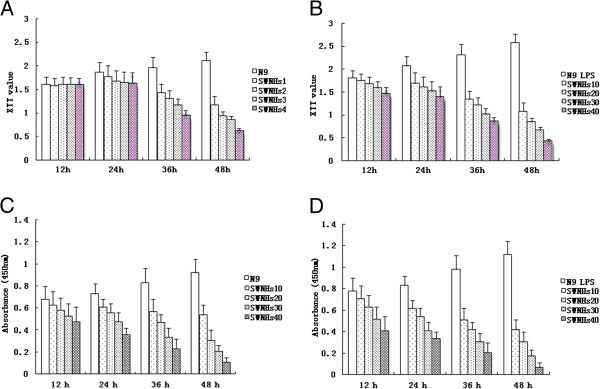
SWNHs inhibited growth and proliferation of N9 cells, especially in pre-treated with LPS. By XTT assays, we investigated the effect of SWNHs on cell growth and found that the growth of N9 cells pre-treated with LPS (B) was much more significantly than N9 cells (A). The growth of cells were significantly inhibited by SWNHs at each time point in a dose-dependent manner (P < 0.001), especially in cells pre-treated with LPS (B). Cell viability was evaluated by CCK-8 assay. The result showed that the proliferation of N9 cells pre-treated with LPS (D) was much more significantly than N9 cells (C). The proliferation of N9 cells treated with SWNHs was significantly inhibited at each time point in a time and dose-dependent manner (C and D). The effect induced by SWNHs on N9 cells pre-treated with LPS (D) was far more than that cells pre-treated without LPS (B). All data are represented as mean ± SEM.